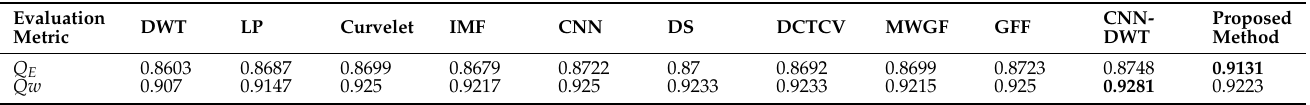
Table 37. The outcomes for the flowerpot image and comparisons with existing techniques in the literature ([25]).